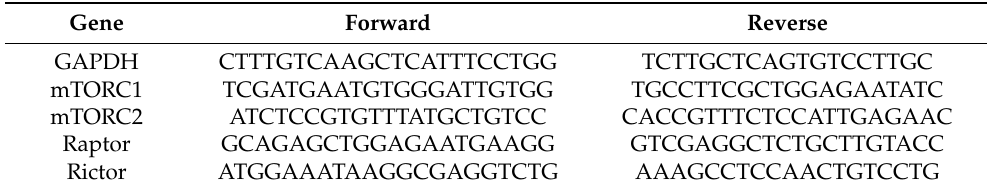
Table 2. PCR primer sequences of mTOR pathway and GAPDH gene in mouse for quantitative polymerase chain reaction